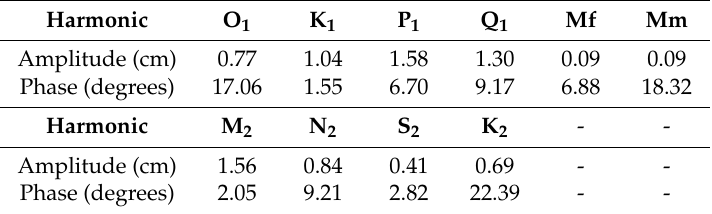
Table 2. Maximum absolute differences in tidal harmonics for the ten forcing constituents used along the entire ENPAC15 boundary for the TPXO8-Atlas and FES2012 global tidal database products.